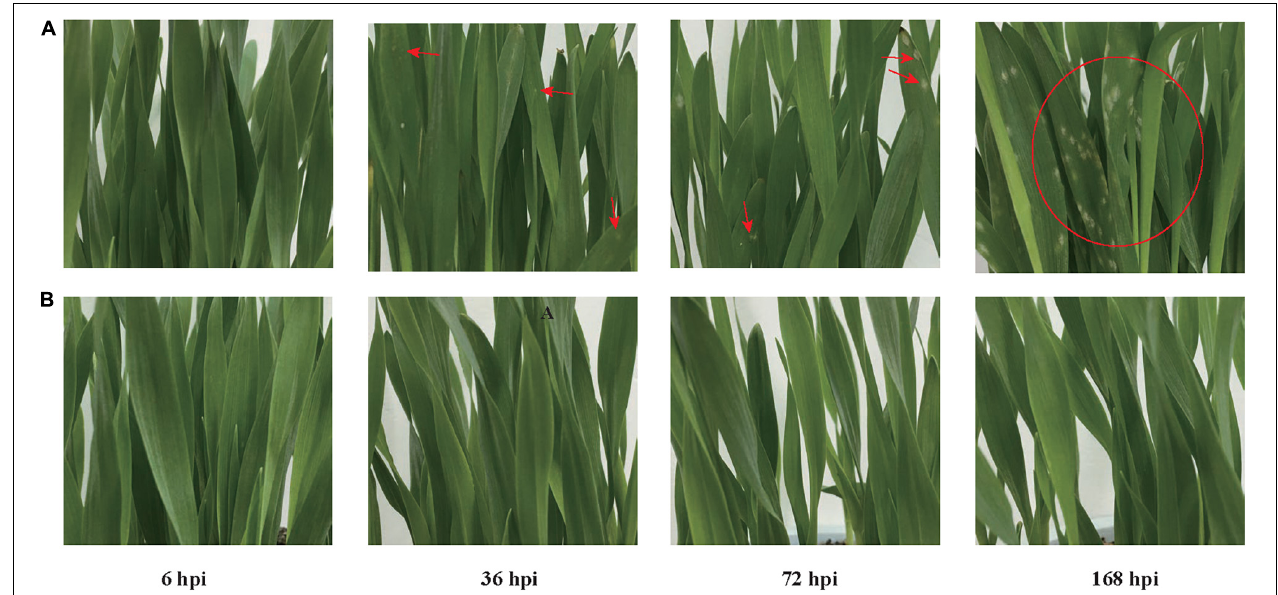
FIGURE 1 | Disease development progression of G72 (one susceptible line to powdery mildew) and K69 (one resistant line to powdery mildew) at 6, 36, 72, and 168 h post-inoculation (hpi). (A) G72 line. (B) K69